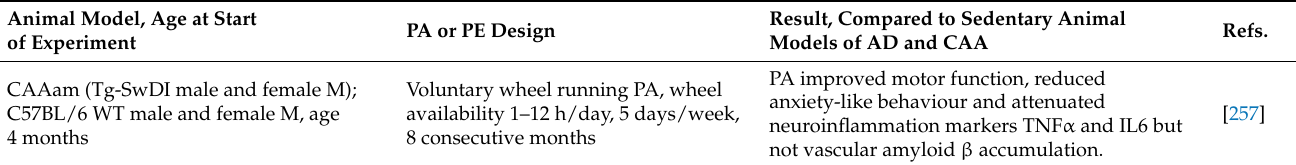
Table 2. Effect of physical activity (PA) or physical exercise (PE) on cognition in animal models of AD and CAA. Abbreviations: CAAam (cerebral amiloid pathology animal model); MT (constant speed motorised treadmill); (FADam) dominantly inherited familial AD animal model; (LOADam) late onset AD animal model; (R) adult rats; (M) adult mice (M); WT (wild